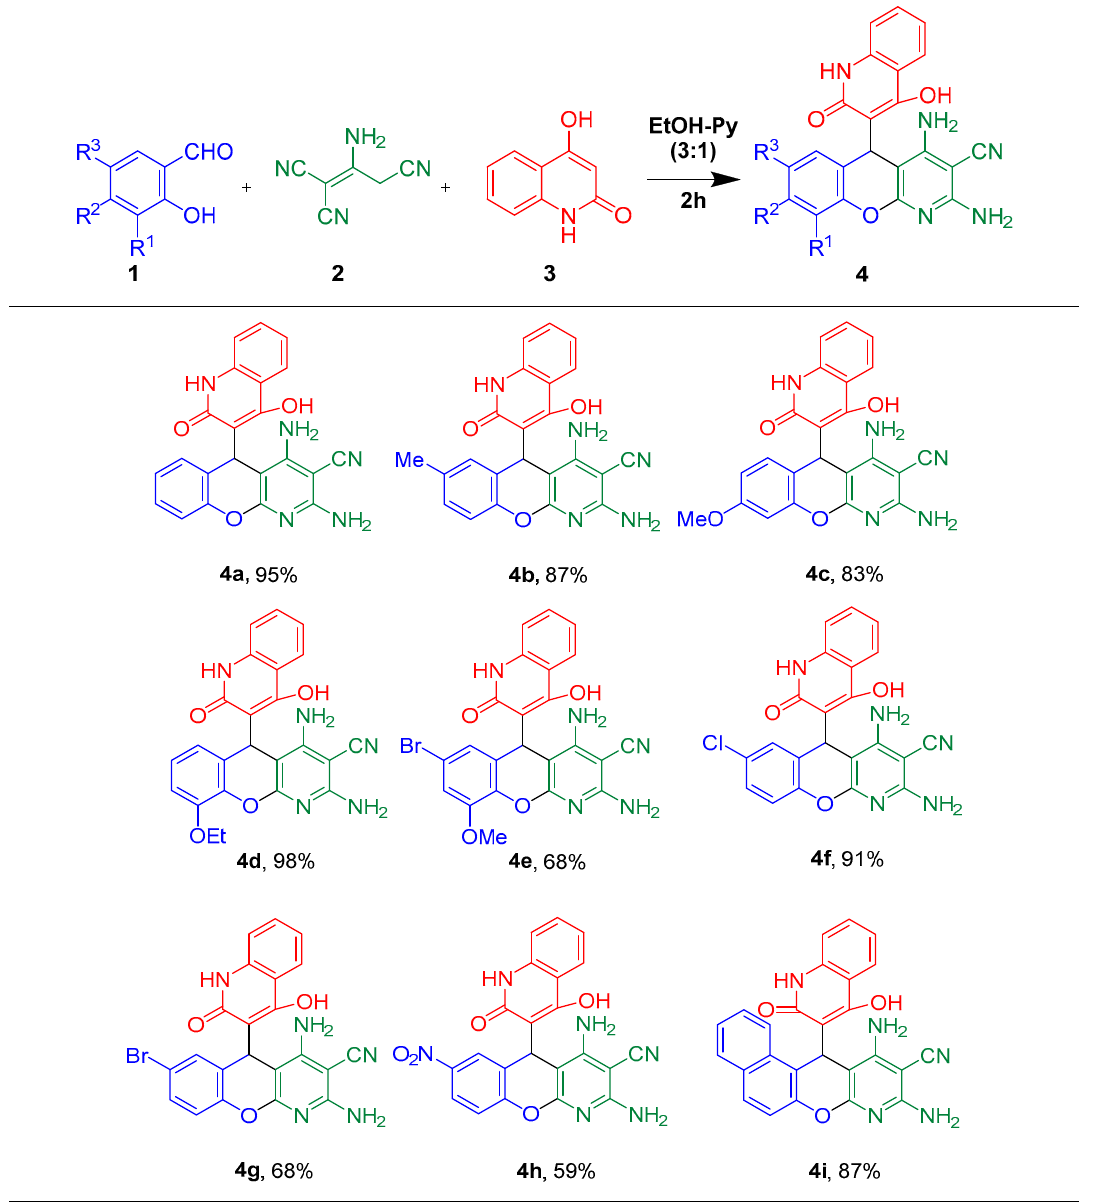
Table 2. PASE reaction of salicylaldehydes 1a–i , malononitrile dimer 2 and hydroxyquinolinone 3 1 .